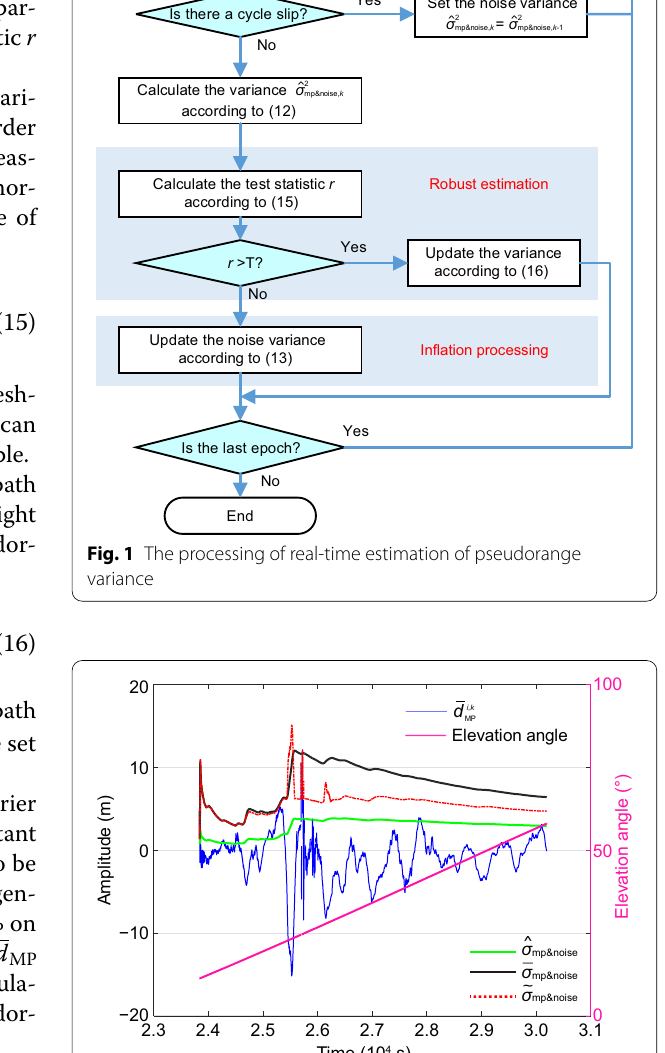
account the influence of the surrounding environment on measurement noise and multipath errors, it can obtain a more accurate estimation of the pseudorange variance and provide better estimation of the pseudor- ange error level than the empirical stochastic model.